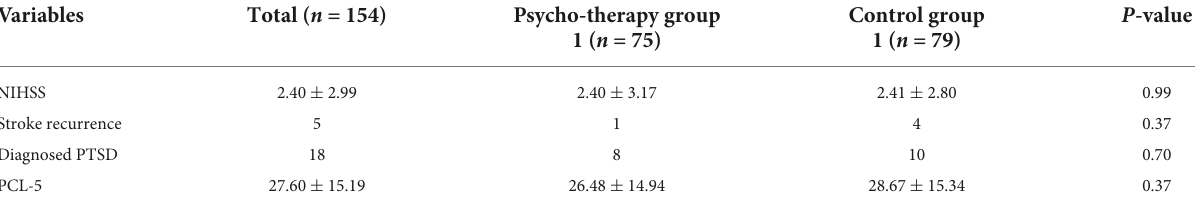
TABLE 3 Parameters of stroke and post-traumatic stress disorder (PTSD) at 2-month follow-up.